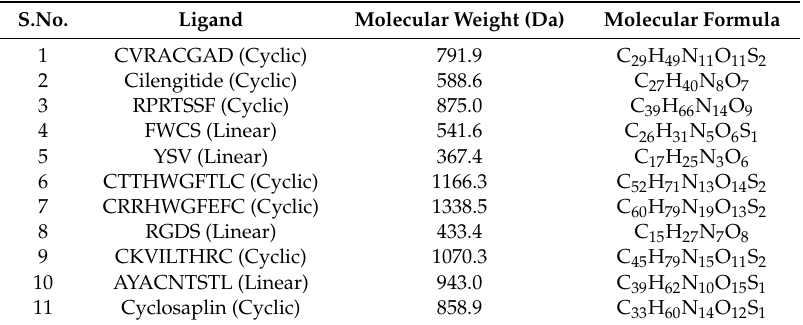
Table 2. Molecular weight and molecular formulae of the ligands.